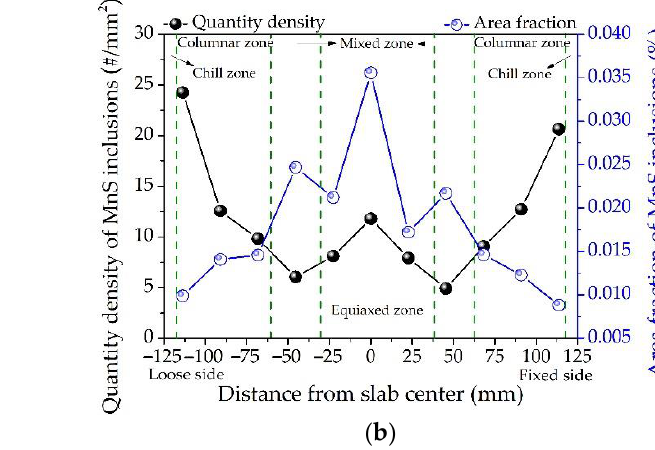
Figure 4. Distribution of MnS inclusions along the slab thickness of medium carbon structural steel 45#: ( a ) average diameter, ( b ) quantity density and area fraction.